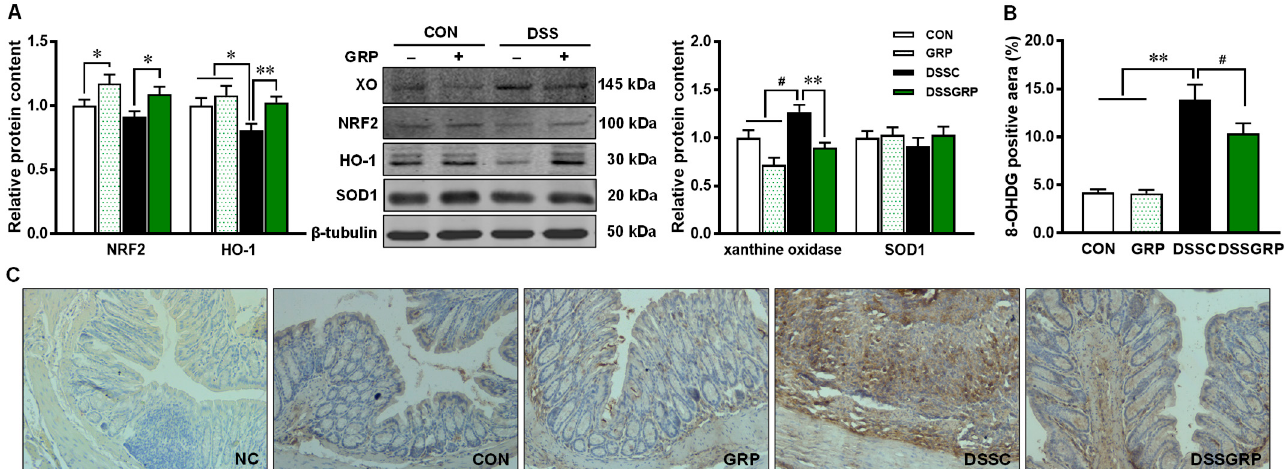
Figure 5. GRP supplementation activates NRF2 signaling and attenuates oxidative stress in the colonic tissues of mice with DSS-induced colitis. ( A ) Relative protein contents of NRF2, HO-1, xanthine oxidase (XO), and SOD1. ( B ) 8-OHdG staining statistics. ( C ) Representative images of 8-OHdG staining. NC: Negative control, CON: Control, GRP: Sulforaphane glucosinolate, DSSC: DSS-treated control mice, DSSGRP: DSS-treated mice with GRP supplementation. n = 8–9 mice per group. # p < 0.10, * p ≤ 0.05, ** p ≤